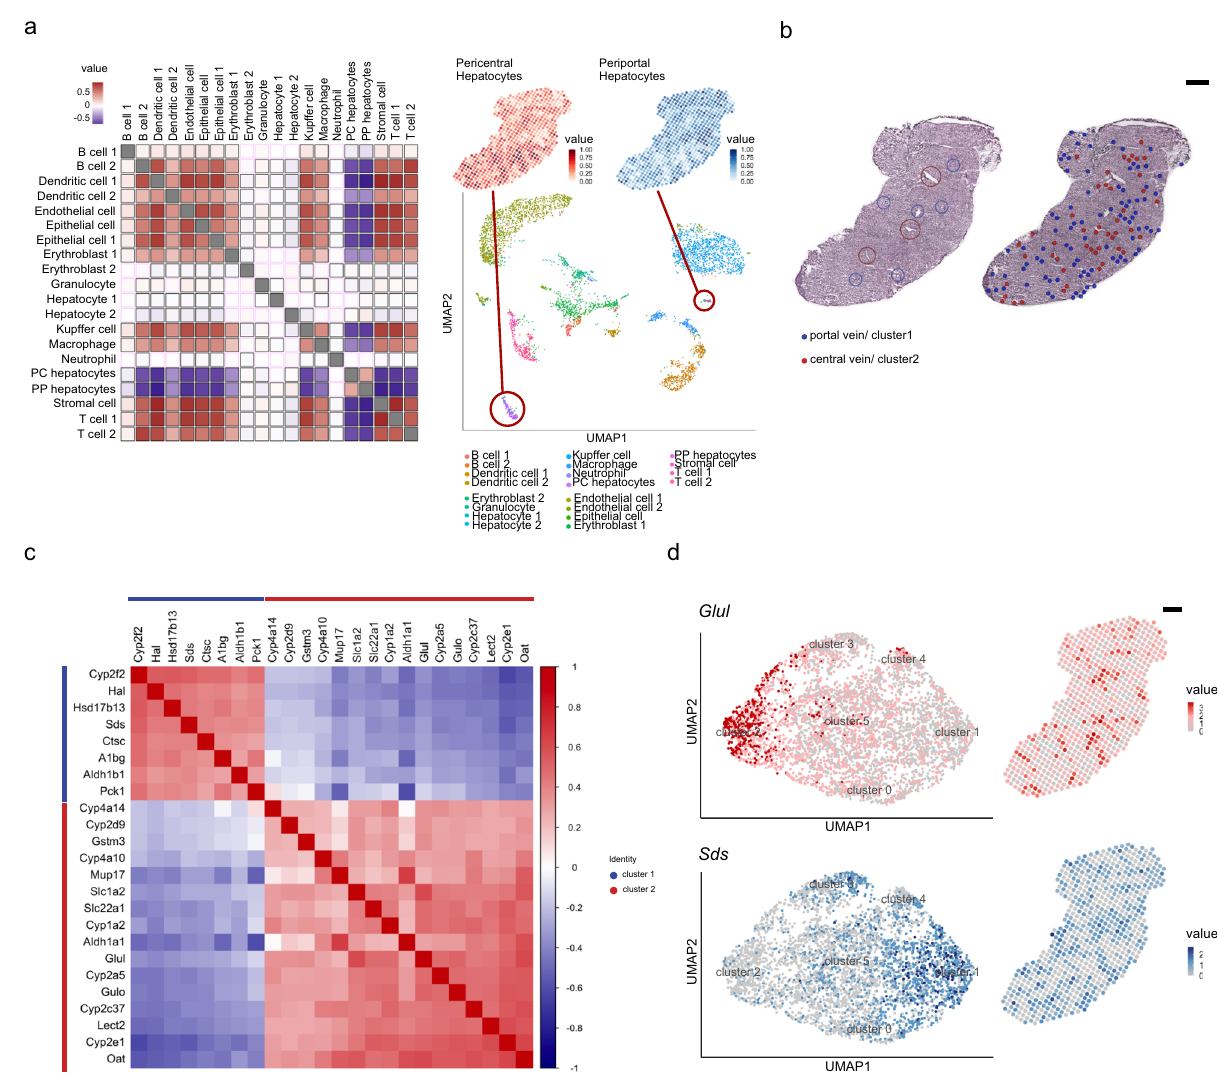
Fig. 2 Clustering, spatial annotation and computational validation using established scRNA-seq data. a Visualization of cell type co-localization by Pearson correlations (left). Positive correlation values indicate spatial co-localization of cell types while negative values represent spatial segregation. Non- signi fi cant correlations are highlighted with magenta borders. UMAP embedding of single cell data of the Mouse Cell Atlas (MCA) 41 grouped by annotated cell types (bottom right). Numeration behind the cell types represent annotation of MCA data (B cell-1: Fcmr high, -2: Jchain high, Dendritic cell-1: Cst3 high, -2: Siglec high, Epithelial cell-1: Spp1 high, -2: /, Erythroblast-1: Hbb-bs high, -2: Hbb-bt high, Hepatocyte-1: Fabp1 high, -2: mt-Nd4 high, T cell-1: Gzma high, -2: Trbcs2 high). Encircled clusters in the plot refer to pericentral or periportal hepatocytes of MCA data. Quantile scales of cell-proportions annotated as pericentral and periportal hepatocytes (Methods) are mapped on Spatial Transcriptomics spot data (top right). b Visualization of spots representing gene expression pro fi les of cluster 1 (portal vein, blue) and cluster 2 (central vein, red) on H&E stained tissue (right), compared with visual histology annotations of central- (red circles) and portal- (blue circles) veins (left) (scale bar indicates 500 µ m). c Pearson correlations of genes expressed in cluster 1 and 2 ordered by their fi rst principal component (Methods). Genes with high expression in the pericentral cluster (cluster 2) show negative correlation with genes highly expressed in the periportal cluster (cluster 1) and vice versa. Genes present within cluster 1 or cluster 2 exhibit positive correlation with genes in the same cluster. d Projection of selected marker genes for central venous expression ( Glul , top) and periportal expression ( Sds , bottom) in UMAP space and spots under the tissue (scale bar indicates 500 µ